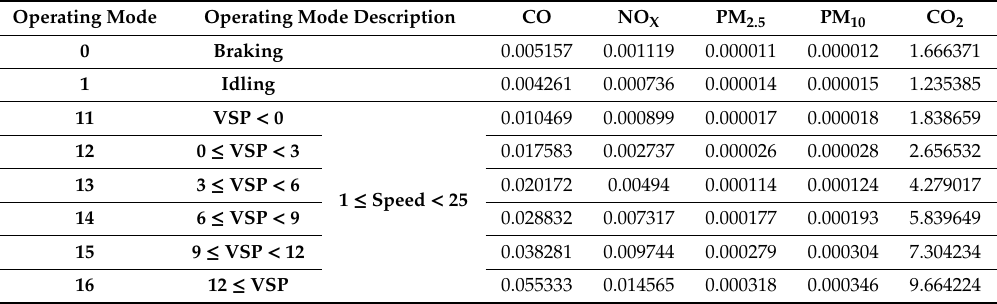
Table A2. Calculated Emission Rates (g / s) by OpMode for a Truck in Gyeonggi-Do,